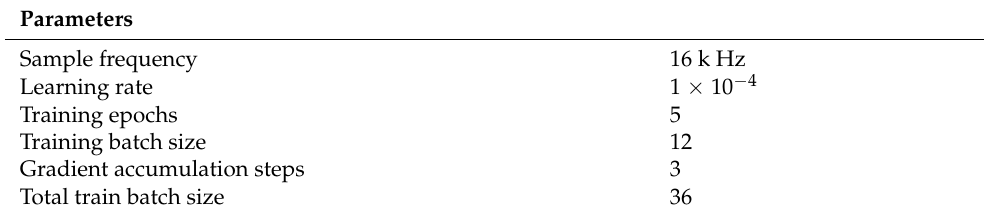
Table 3. Hyper-parameters used for fine-tuning the Wav2Vec 2.0 model.